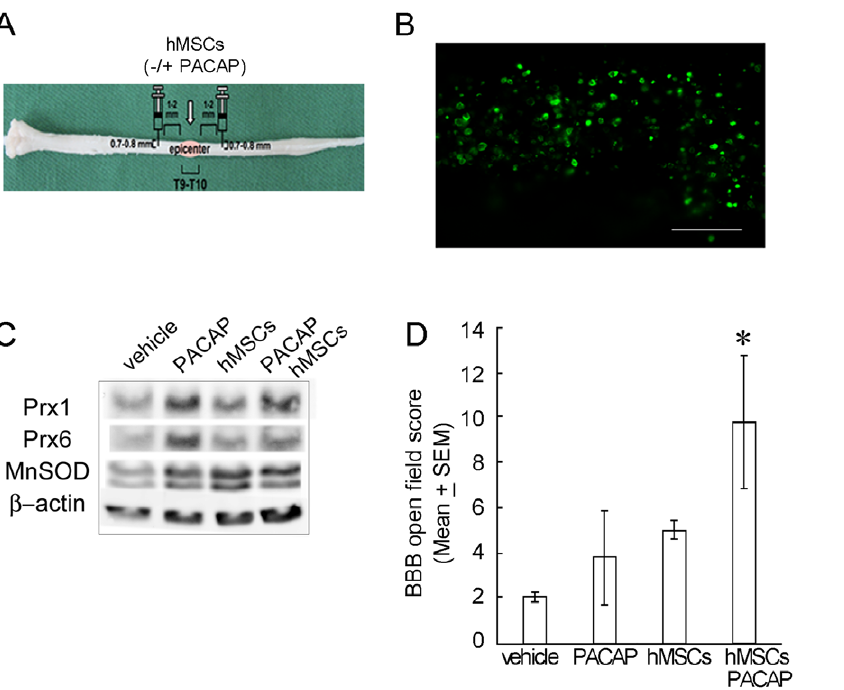
Figure 3. Antioxidant proteins and hindlimb locomotion increased by delayed combinatorial therapy of PACAP and hMSCs. (A). The diagram shows the location of the administration of hMSCs and PACAP into 1–2 mm rostral and caudal to the lesion center at day 7 post severe SCI. (B) Immunostaining for human nucleus (HuNu) was carried out to identify transplanted hMSCs (green) at day 7 after hMSC transplantation. Many hMSCs were present in the injected zone proximal to the lesion center of the spinal cord. Scale bar in B, 50 m m. (C). The injured spinal cords were collected at day 14 after SCI. The lesion center with the length of 4–5 mm was dissected from the injured spinal cord tissues, subjected to protein extraction. The expression levels of selected antioxidant proteins as indicated above were examined by western blotting. The same blot was stripped and reprobed with b -actin antibodies as internal loading control. (D). At day 31 after SCI, rats with severe SCI were subjected onto an open-field to evaluate their hindlimb locomotion using Basso Beattie Bresnahan (BBB) locomotor rating analysis. Data are presented as mean 6 SEM. * p , 0.05 versus vehicle, PACPA, or hMSCs.